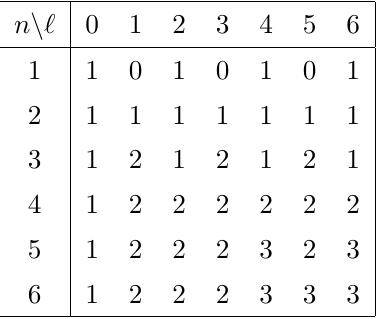
Table 2 . Number of B ‘ for the representation of dimension n for the group